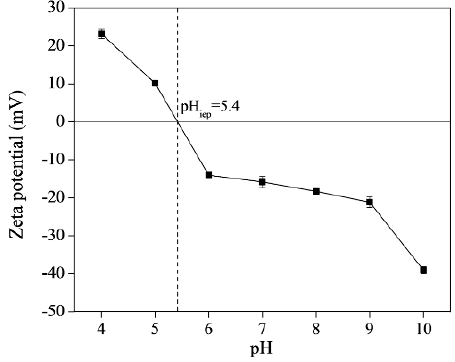
Figure 7. Zeta potential of MGO at different pH values.